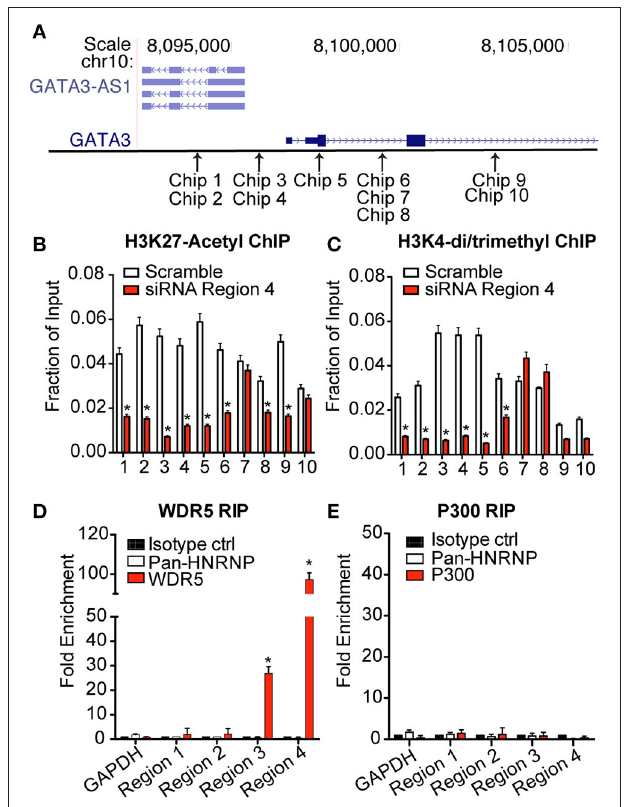
FIGURE 4 | Expression of GATA3-AS1 changes chromatin marks throughout the GATA3-AS1 - GATA3 gene locus . TH2 cultures were transfected with an siRNA specific for GATA3-AS1 region 4 or a scrambled control siRNA on day 2 as described in Figure 3 . Cultures were harvested and processed for ChIP assays on day 5. Results are expressed as fraction of input, mean ± S.D. ( n = 3). * P < 0.05. (A) Approximate genomic positions of PCR primers used for ChIP assays. (B) ChIP assays for H3K27ac. (C) ChIP asays for H3K4me3. (D) WDR5 was immunoprecipitated from TH2 effector whole cell lysates. RNA was isolated from immunoprecipitated WDR5, and GATA3-AS1 regions 1–4 determined by qPCR. Results are expressed as fold enrichment relative to isotype control, mean ± S.D. ( n = 3). * P < 0.05. (E) As in (D) , except an antibody to p300 was employed for RNA